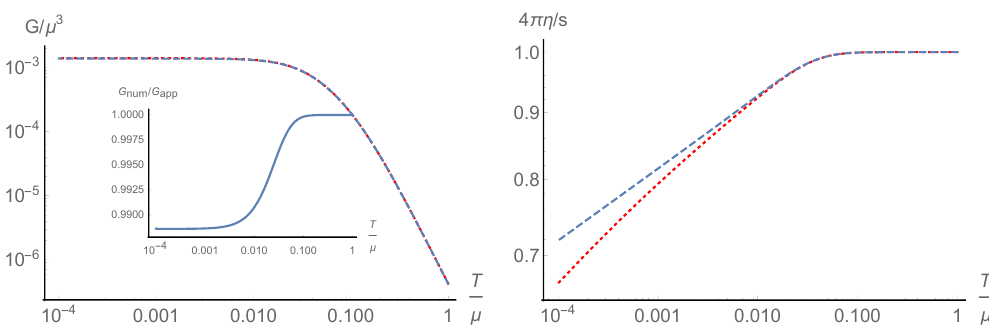
Figure 1 . In both plots, the blue dashed curve is the exact numerical result from the Kubo formul(cid:26) (2.10); the red dotted curve is the approximation (3.31). In the inset, the ratio between the two show a small deviation as temperature decreases. The shear viscosity shows a small sublinear deviation from s= 4 (cid:25) as T